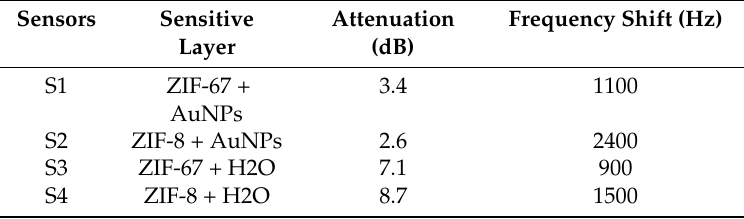
Figure 7. Spectral response of the LW sensors ( a ) without ( b ) with ZIF8 and ( c ) with ZIF67 layers. Table 2. Insertion loss and frequency shift with respect to the reference sensor, 165 MHz and 18.3